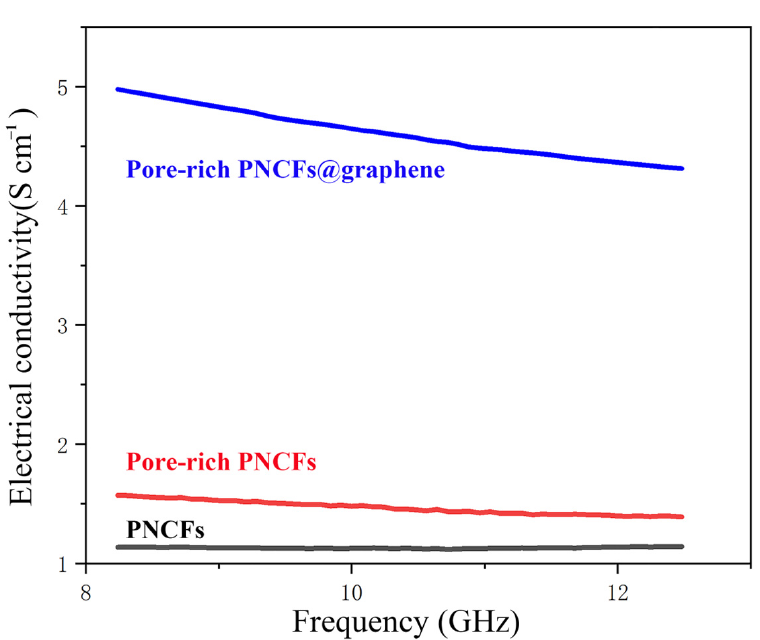
Figure 5. Electrical conductivity of the PNCFs, pore-rich PNCFs, and pore-rich PNCFs@graphene.